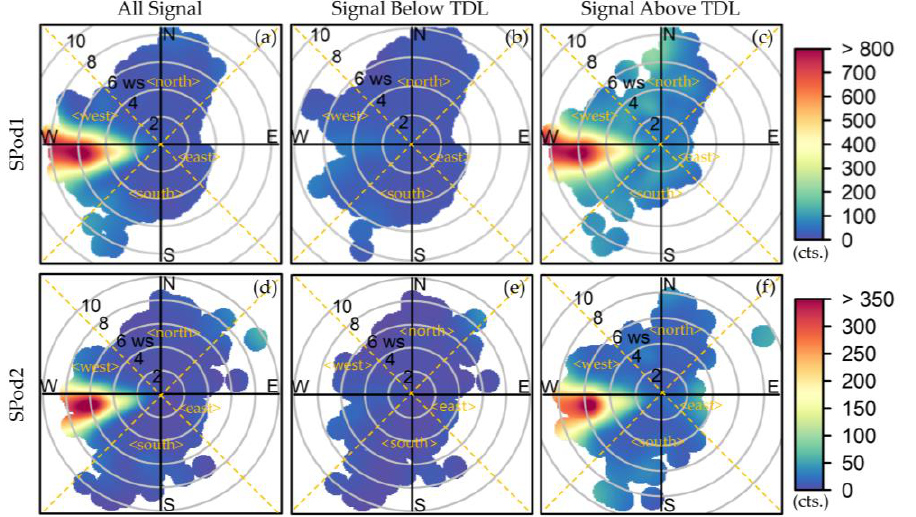
Figure 5. SDI plots for ( a – c ) SPod1; ( d – f ) SPod2, with ( a , c ) including all data consisting of